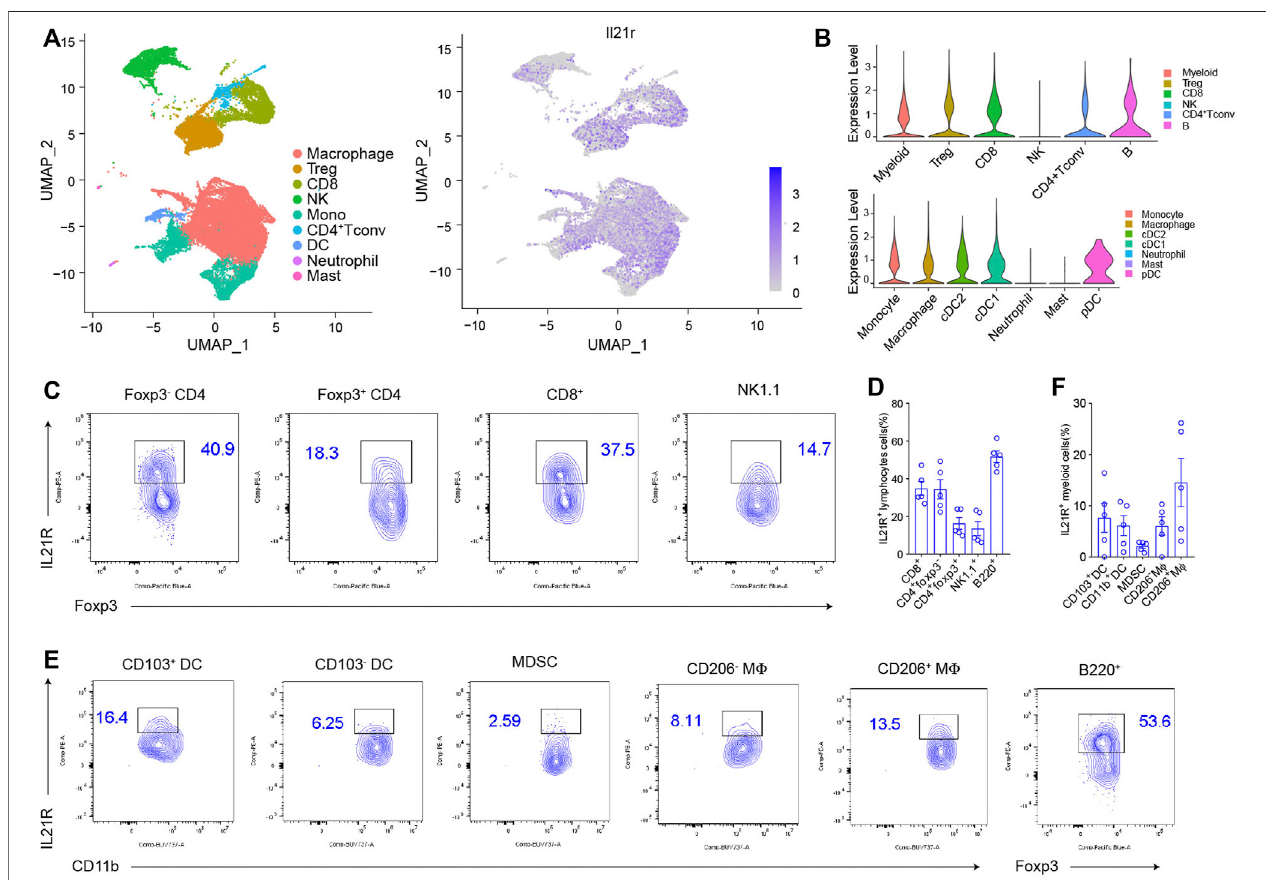
FIGURE1| IL21Rwasdifferentiallyexpressedamongtumor-in fi ltratingimmunecells (A) Clusteranalysis.ImmunecellsfromvaccinatedMC38miceweredrawnby uni fi ed manifold approximation and projection (UMAP) dimensionality reduction of scRNA-seq data, and were colored by the expression of IL21R. (B) Violin plot shows theexpressionofIL21Rindifferentimmunecellsubsets.Eachdotrepresentsasinglecell. (C) Representative fl owcytometryscatterplotsofIL21Rexpressionontumor- in fi ltrating lymphocytes. (Foxp3 - CD4 + : CD45 + CD4 + Foxp3 - , Foxp3 + CD4 + : CD45 + CD4 + Foxp3 + , CD8 + : CD45 + CD8 + , NK cell: CD45 + CD8 - CD4 - NK1.1 + , B cells: CD45 + CD8 - CD4 - B220 + ). (D) Quantitative percentage of IL21R in various immune cells. (E) Representative fl ow cytometry analyses of IL21R expression on tumor- in fi ltrating myeloid cells (CD103 + DC: CD45 + Gr1 - MHCII + CD24 + CD103 + , CD103 - DC: CD45 + Gr1 - MHCII + CD24 + CD103 - CD11b + , MDSC: CD45 + CD11b + Gr1 + , CD206 - M φ : CD45 + Gr1 - MHCII + F4/80 + CD206 - Arg-1 - , CD206+M φ : CD45 + Gr1 - MHCII + F4/80 + CD206 + Arg-1 + ). (F) Quantitative percentage of IL21R in various immune cells.